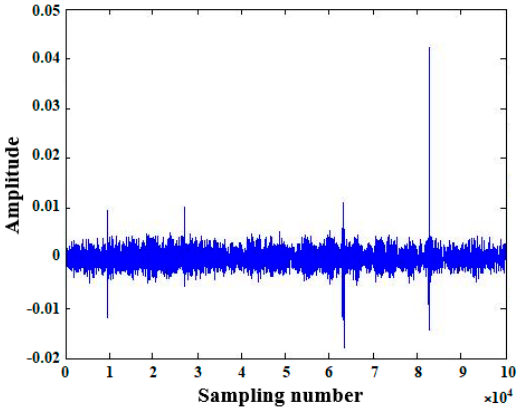
Figure 2. Original underwater acoustic signals.